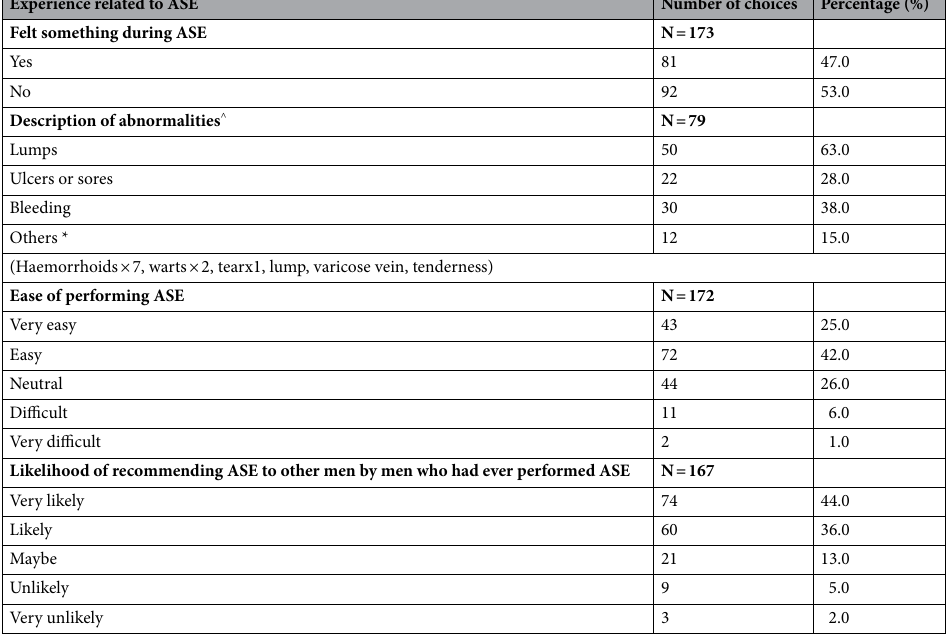
Experience related to ASE Number of choices Percentage